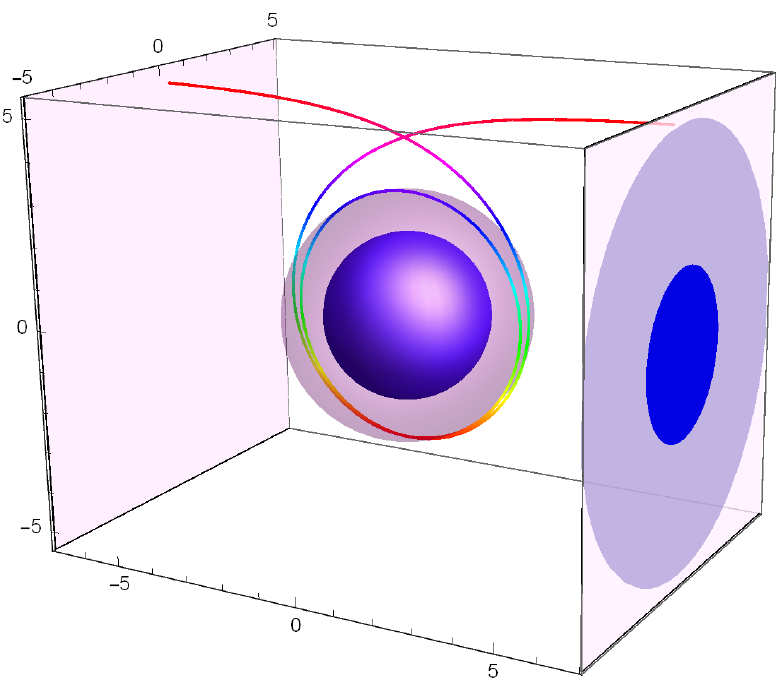
Figure 1. The classical shadow (lighter blue disk) of the Schwarzschild black hole ( a = 0), highlighted by a distant luminous background. A typical 3D photon trajectory is shown (multicolored 3D curve), which starts from the distant background. Then, this trajectory winds multiple times near the radius of circular photon orbit around the black hole event horizon globe (darker blue sphere) at the return radius r min = r ph = 3. The finishing point of this photon trajectory is the north polar point on the outline of the black hole shadow, viewed by a distant observer. Inside the black hole shadow is shown a fictitious image (dark blue disk with a radius r = 2) of the lensed image of the black hole event horizon in the imaginary Euclidean space (in the absence of gravity). The circular orbits of photons, producing the outline of shadow, are placed on the purple photon sphere with the radius r =